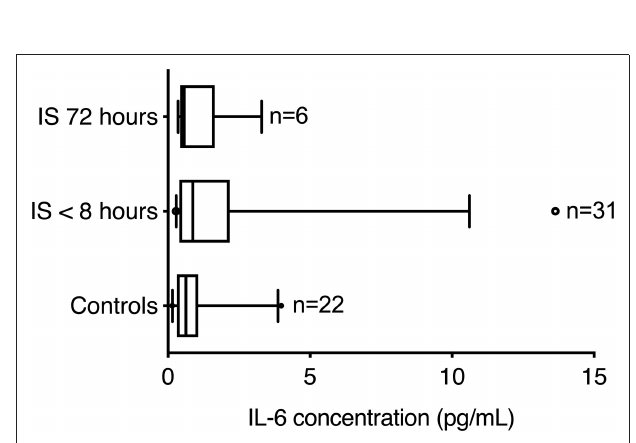
FIGURE 3 | Interleukin-6 levels in patients with ischemic stroke. Blood IL-6 concentrations (pg/mL) were similar in healthy controls and ischemic stroke patients (CV = 4.1%). Line: median. Box: interquartile range. Whiskers: 5th–95th